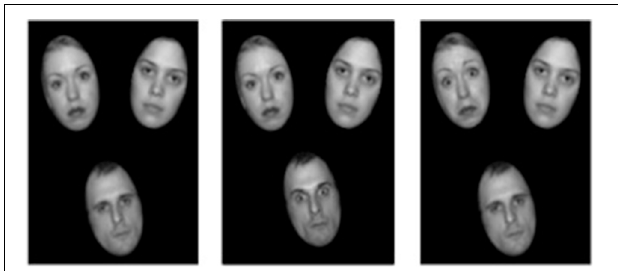
FIGURE 1 | Example displays for neutral, emotional (fearful) non-target singleton and emotional (fearful) target singleton conditions. The location of each of the face identities and emotion conditions (emotional target, emotional distractor, or neutral) was randomly assigned to one of the three display positions on each trial. Equivalent displays were used for blocks with angry and happy faces as specified in the method